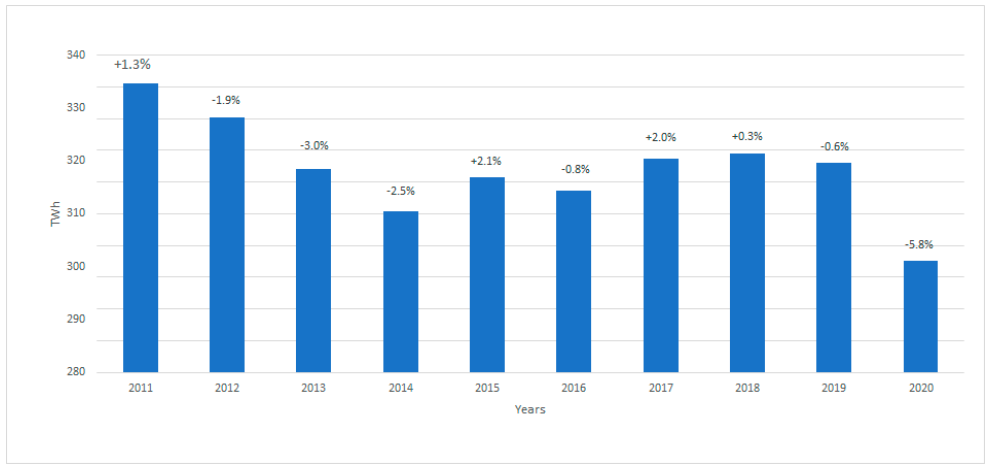
Figure 5. Historical Italian demand profile. The percentage change refers to the previous year.